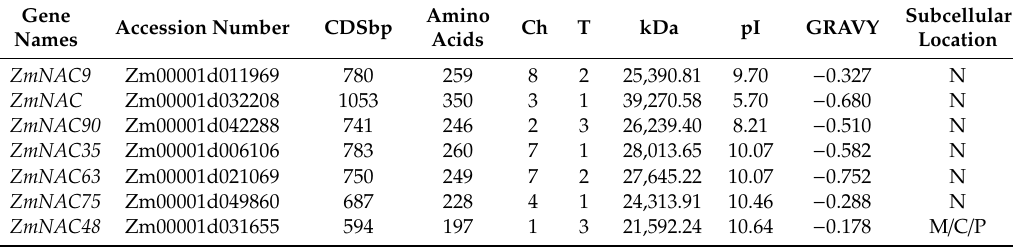
Table 1. Molecular characteristics of ZmNAC19 homologous genes in maize.